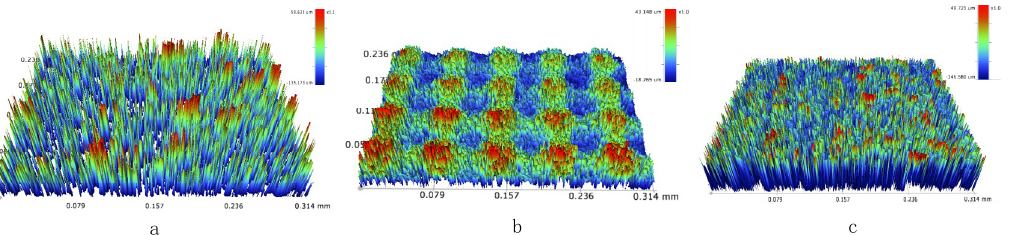
Figure 2. SEM image of copper plate surface after laser ablation and heat treatment: ( a , b ) scanning speed: 100 mm/s, scanning interval: 0.005 mm; ( c , d ) scanning speed: 1300 mm/s, scanning interval: 0.005 mm; ( e , f ) scanning speed: 1300 mm/s, scanning interval: 0.02 mm. 1—nanostructures; 2—slender columnar structures.